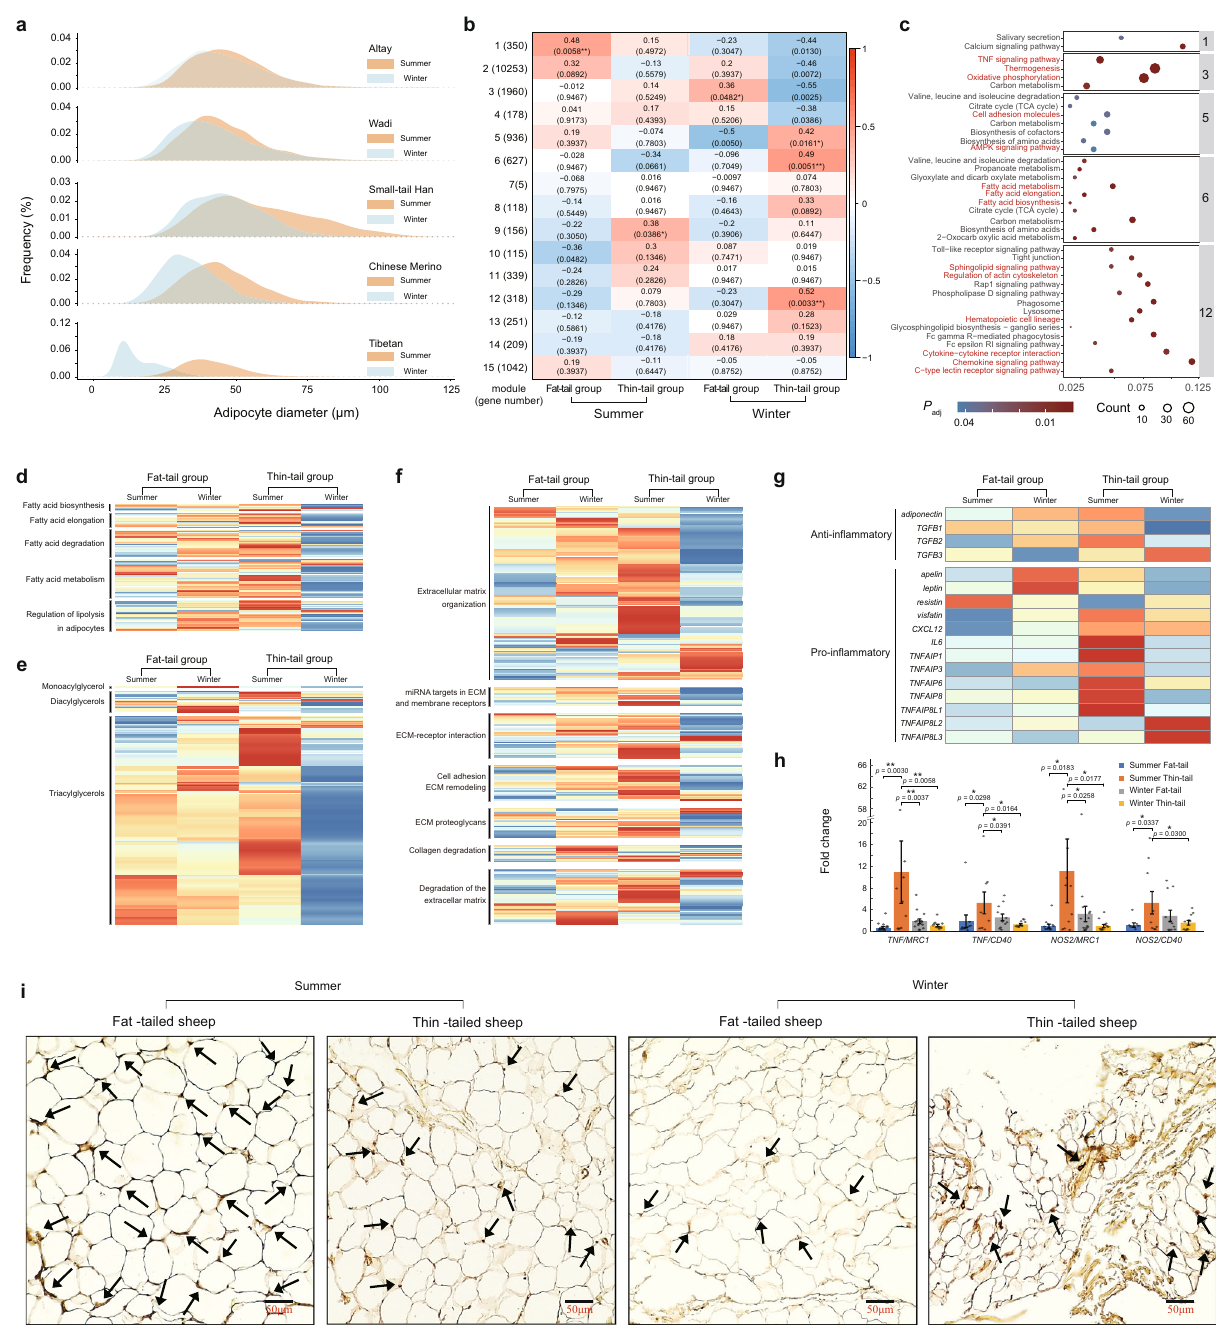
Fig. 4 Variations in cell size, metabolism, ECM, and in fl ammatory reactions among tail adipose tissues with different fat deposition capacities in different seasons. a Adipocyte size distribution of tail fat from Altay, Wadi, Small-tailed Han, Chinese Merino, and Tibetan sheep in summer and winter. b Correlation between the identi fi ed WGCNA modules and the four adipose tissue groups (summer-fat tail, summer-thin tail, winter-fat tail, and winter- thin tail). Modules associated with the traits with correlation coef fi cient > 0.3 and P adj value < 0.05 were considered to be signi fi cant at the levels of * P adj value < 0.05 or ** P adj value < 0.01. Red and blue colors s indicate signi fi cant and nonsigni fi cant correlations with gene expression, respectively. c Enrichment of the modules signi fi cantly associated with four adipose tissue groups. d Expression heatmap of genes in fatty acid metabolism related pathways among the four adipose tissue groups. e Heatmap of glycerol composition among the four adipose tissue groups. f Expression heatmap of genes in extracellular matrix (ECM) related pathways among the four adipose tissue groups. g Expression heatmap of anti- and pro-in fl ammatory genes among the four adipose tissue groups. h Changes in M1/M2 cytokine gene expression (RT ‒ qPCR) among the four adipose tissue groups. ** P value < 0.05; ** P value < 0.01; bars represent the standard error of the mean. i F4/80 staining in adipose tissues from the four groups of season-tail combinations. These plots ( a – c ) are based on results in Supplementary Data 29 – 32, and plot h is based on results in Supplementary Data